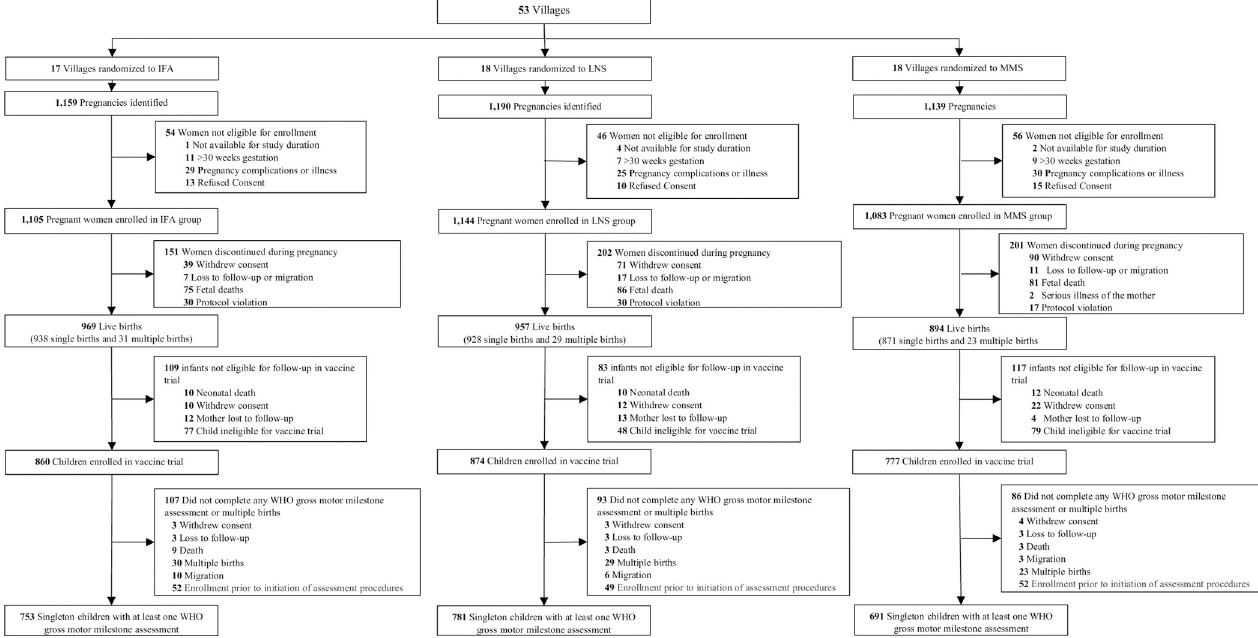
Fig 2. CONSORT flowchart for WHO motor milestone assessments. BSID-III, Bayley Scales of Infant and Toddler Development III; IFA, iron–folic acid supplements; LNS, lipid-based nutrient supplements; MMS, multiple micronutrient supplements; WHO, World Health Organization. https://doi.org/10.1371/journal.pmed.1003984.g002 ( p -value for interaction 0.03). The trajectory of cognitive scores from 6 to 24 months of age dif- fered for children whose mothers were randomized to the LNS group as compared to the IFA group (Fig 3: p -value for difference in trajectory < 0.001). The LNS group had significantly higher cognitive scores at 18 and 21 months as compared to IFA (Table J in S1 Appendix), and the magnitude of the difference was relatively large at approximately 1.4 points, which equated to approximately 0.35 SD at each time point. There was no difference in BSID-III language and motor score trajectories from 6 to 24 months of age for the LNS as compared to the IFA group (Figs 4 and 5, respectively, p -values > 0.05). Children whose mothers received LNS had significantly earlier achievement of sitting alone and walking alone as compared to IFA ( p -val- ues < 0.05), but there was no difference between prenatal LNS and IFA groups in time to achievement of sitting without support, standing with assistance, hands-and-knees crawling or walking with assistance (Table 3, survival plots presented in Figs A-F in S1 Appendix). The findings of the effect of LNS on time to achievement of motor milestones were consistent in sensitivity analyses using multivariable models (Table I in S1 Appendix).